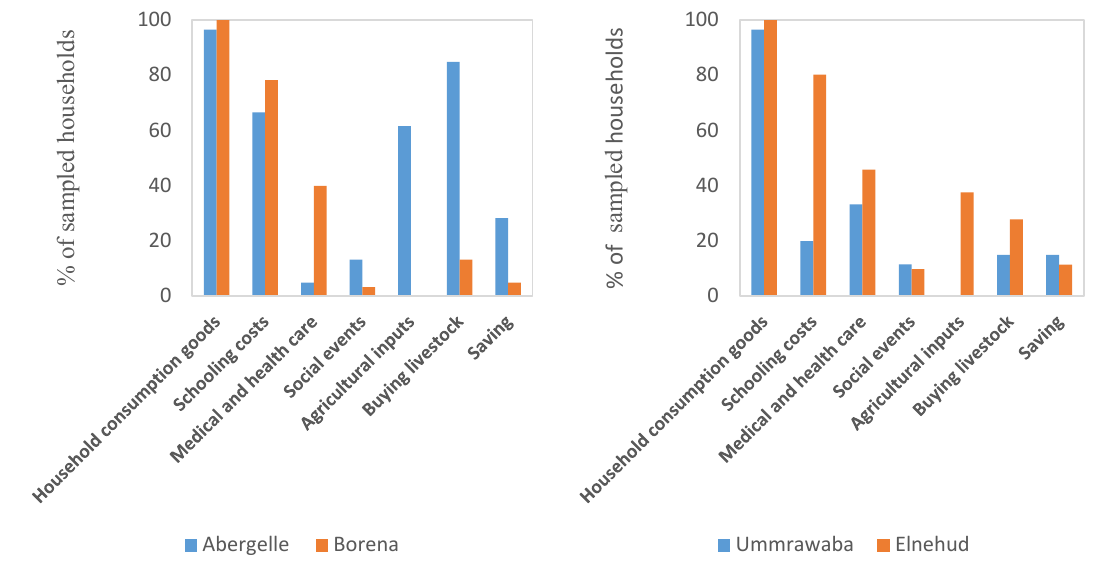
Figure 5. Proportion of households spending gum and resin income on major expenditure items (the percentages do not sum up to 100 as the extra gum and resin incomes are spent for more than one expenditure